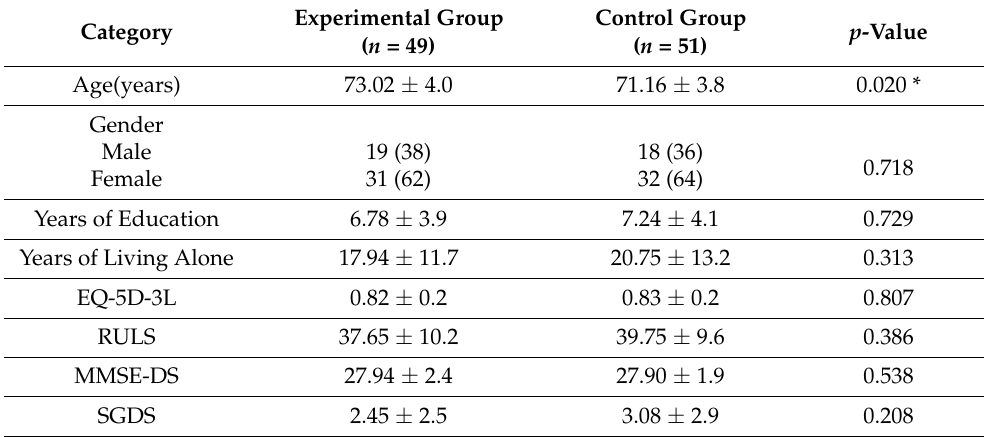
Table 1. General characteristics of participants in the experimental group and the control group.